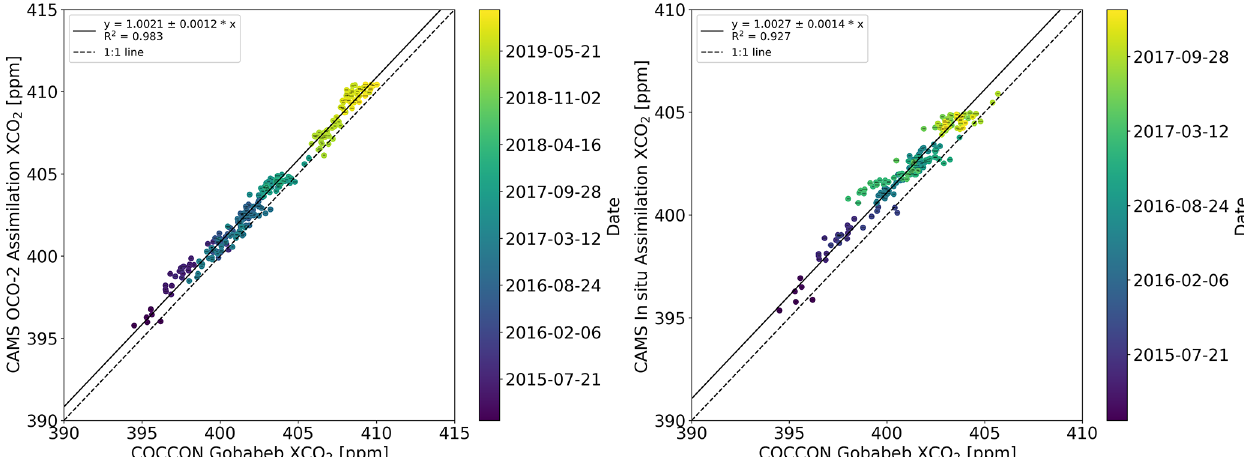
Figure 15. XCO 2 correlation plots between coincident COCCON Gobabeb observations and CAMS model data. The left panel shows the OCO-2 assimilated model data; the right panel shows the in situ assimilated model data. Note that the OCO-2 assimilated data are available until 2019 and the in situ assimilated data are available until 2018. Error bars denote the 1 σ standard deviation of the hourly mean values for COCCON